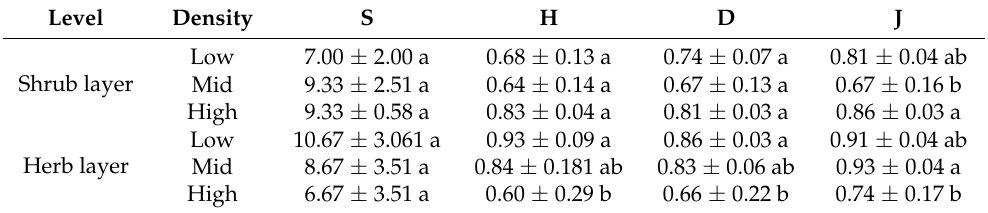
Table 3. Understory plant species diversity index of the Pinus massoniana plantation with differ- ent